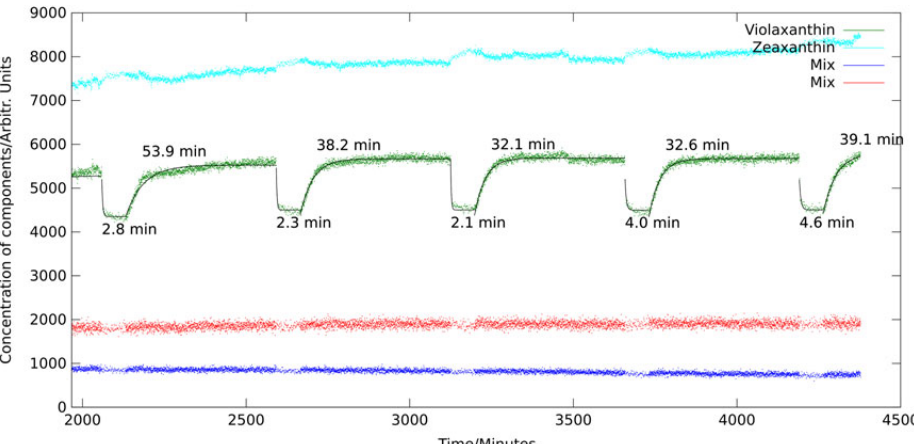
Figure 13. Kinetics of the light-to-dark and dark-to-light transition response of violaxanthin (green) and zeaxanthin (cyan). The upper level of the violaxanthin trace marks the dark-adapted state, the lower level the state at excess light conditions. The zeaxanthin trace shows the complementary kinetics, albeit weakly. The two nearly constant traces (red and blue) represent chlorophylls and carotenoids not directly involved in the violaxanthin cycle reactions. Consequently, those do not show variable concentration in reaction to light stress (reproduced with permission from